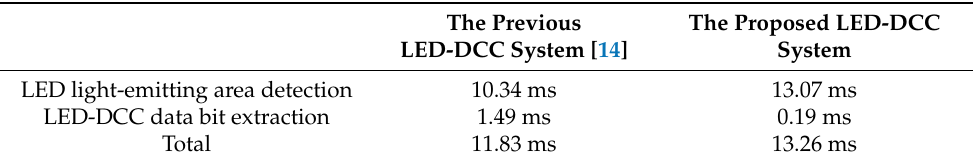
Table 2. The average data decoding latency for data